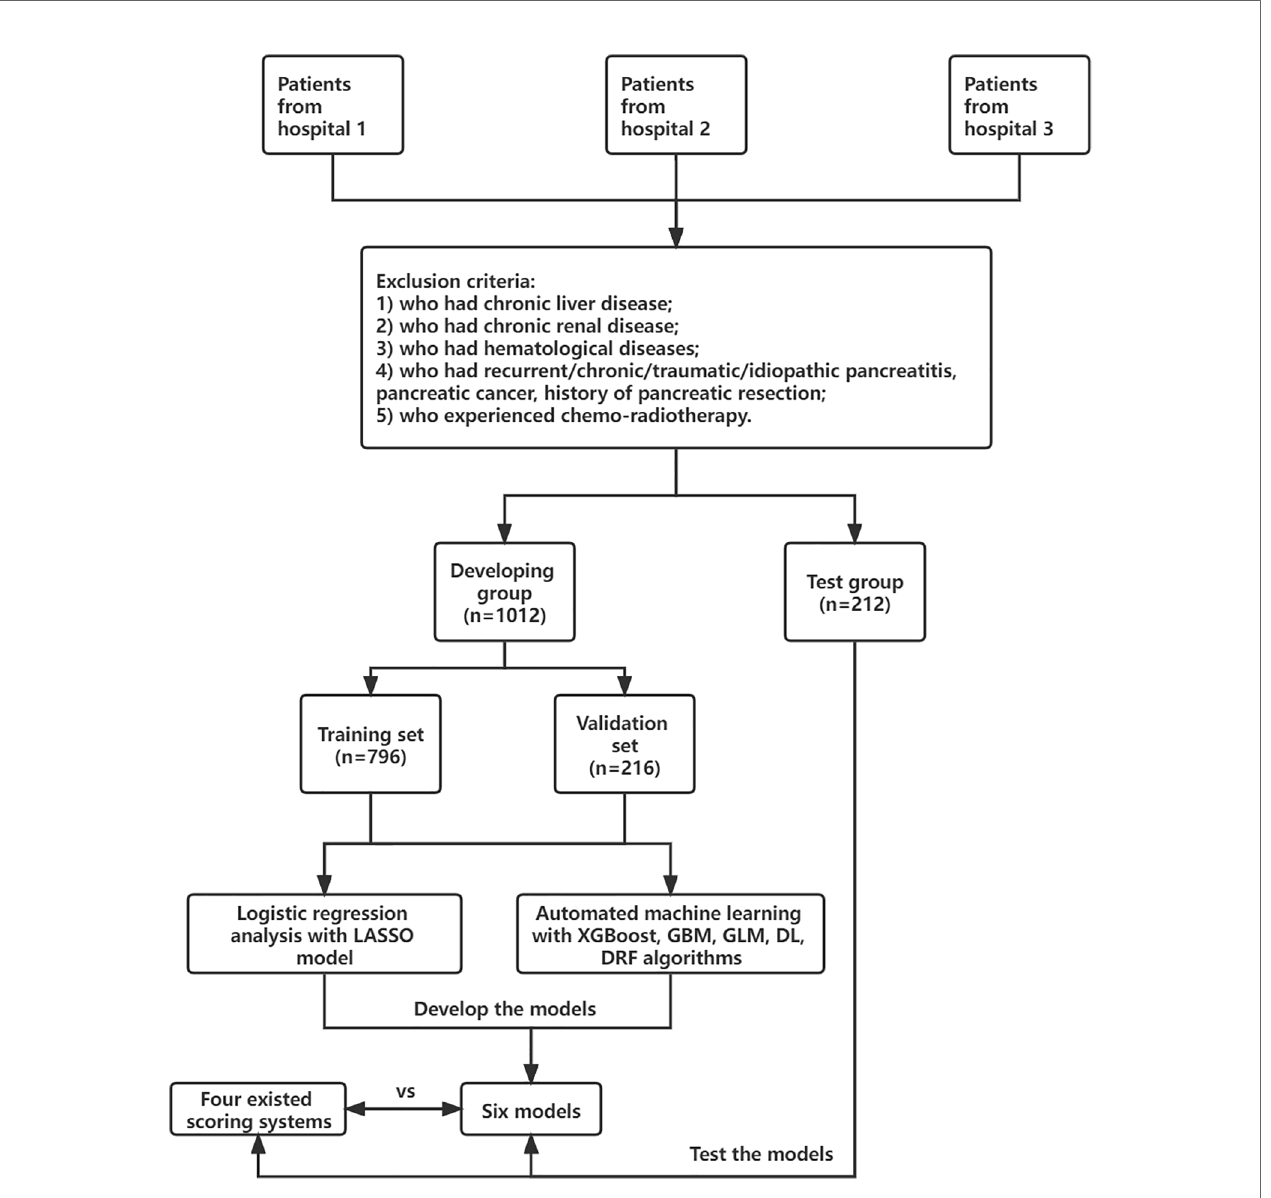
FIGURE 1 | The fl ow chart of this